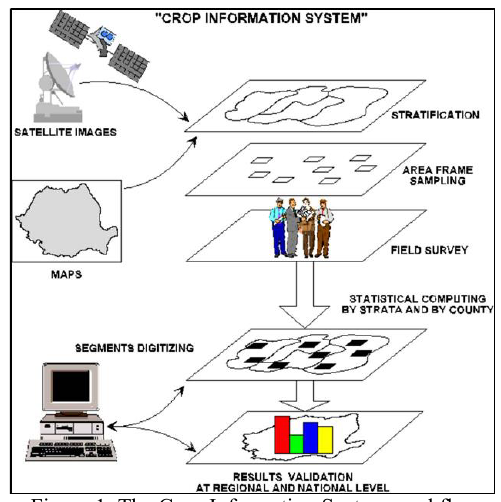
Figure 1. The Crop Information System workflow